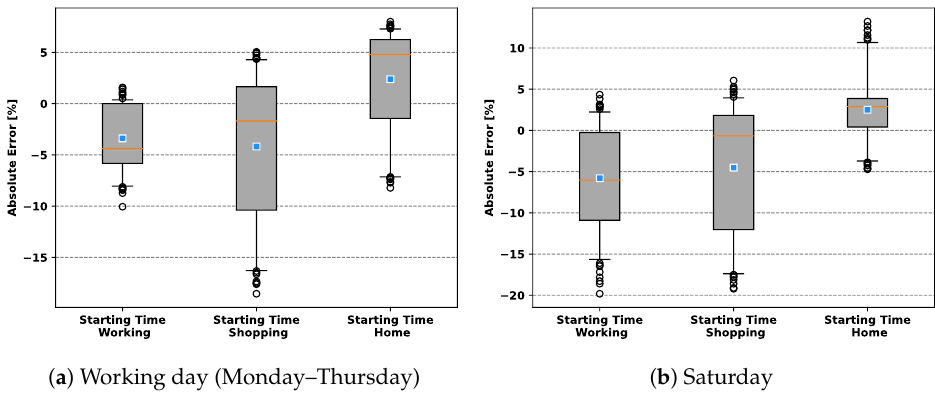
Figure 10. Modelling error starting time distributions.